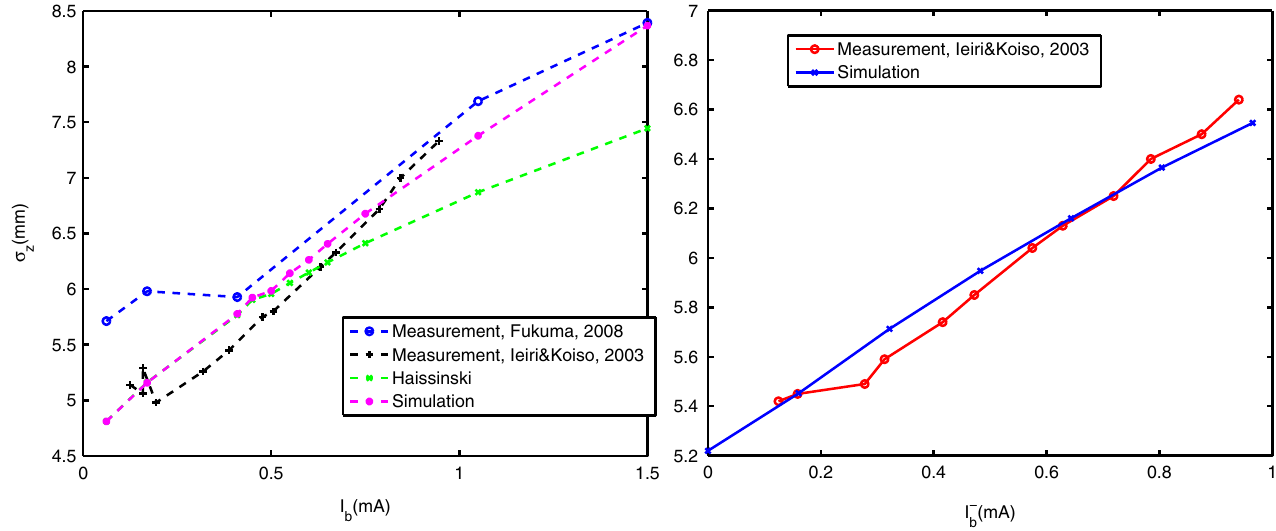
FIG. 4. (Color) Comparisons of bunch length from measurement, calculation, and simulation. The figure on the left is for the LER and the right for the